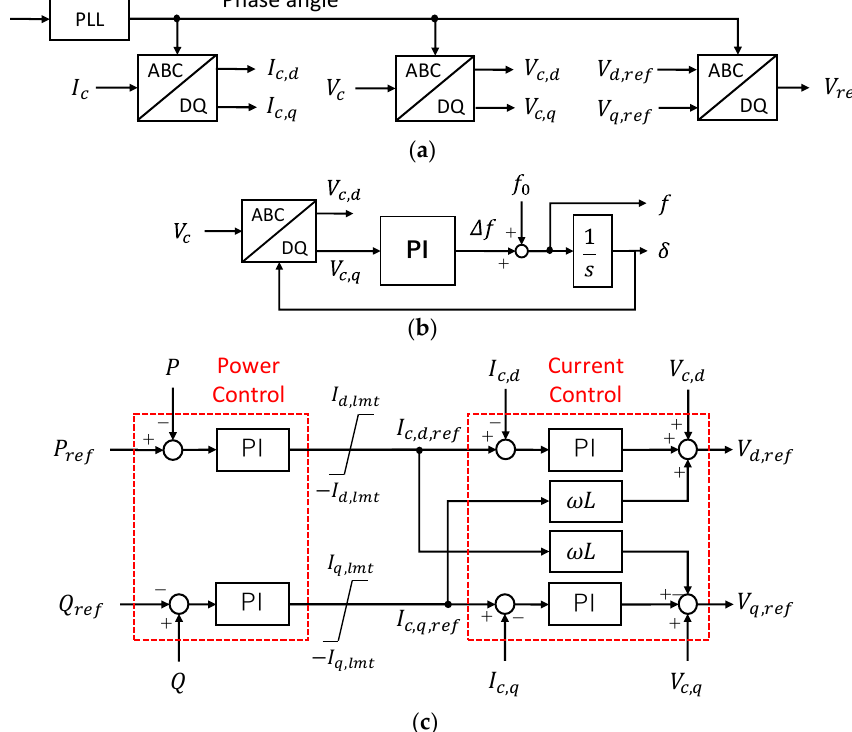
Figure 5. Controller model of the conventional converter. ( a ) Park’s transformation of the signals addressed in the controller, ( b ) the PLL model, and ( c ) a block diagram.